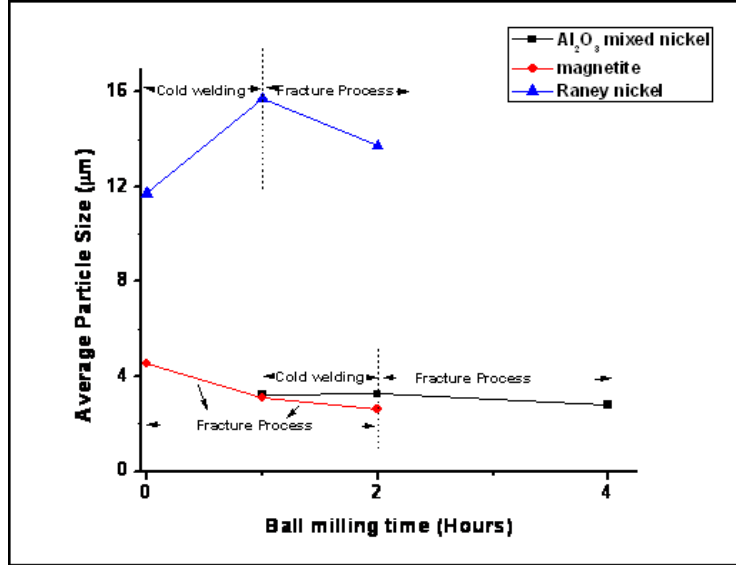
Figure 4. Change of average particle size of catalysts with milling